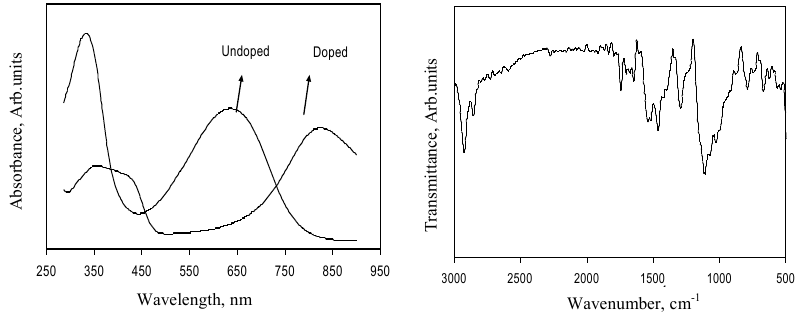
Figure 2 . (a) UV-visible spectra (b) FTIR spectra of DSBA doped tetraaniline prepared.